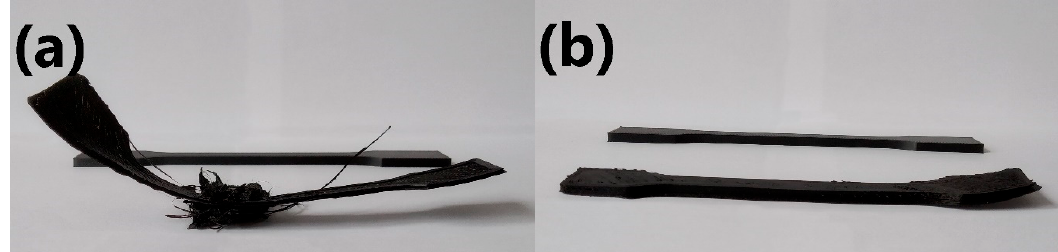
Figure 8. Unsuccessful and successful 3D-printed specimens of ( a ) POM/2.5EVA and ( b )